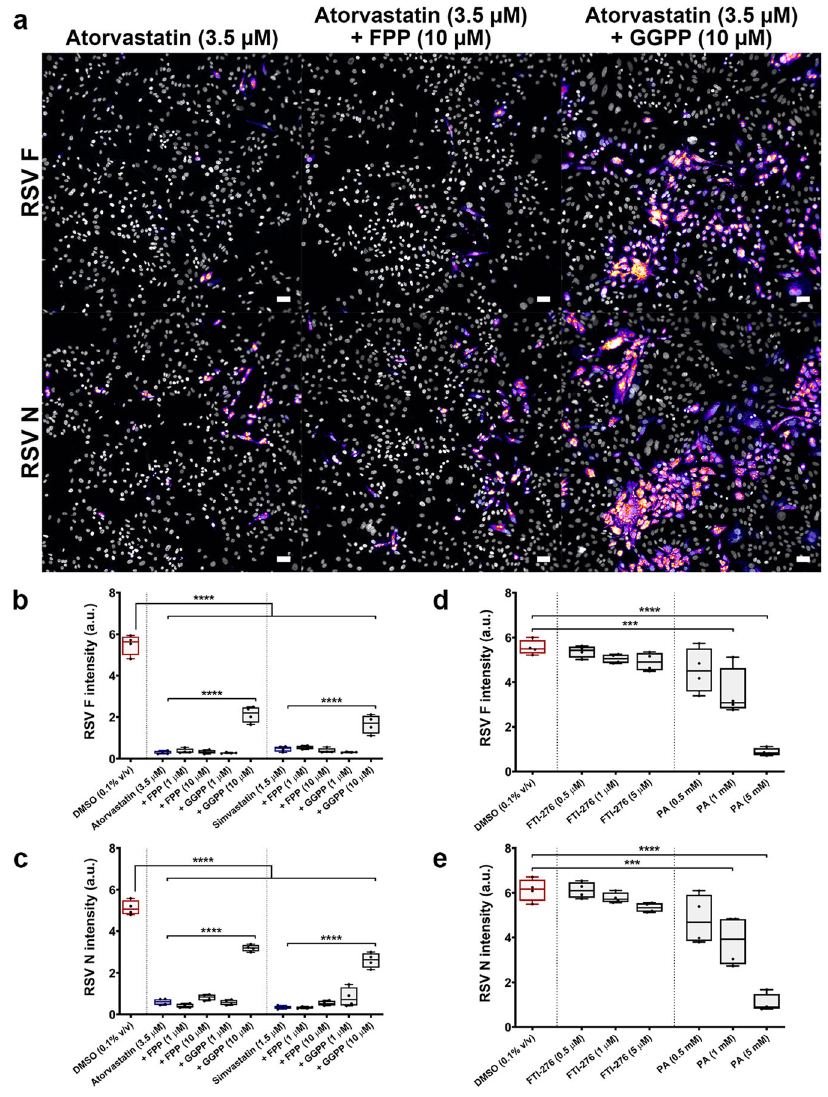
Fig. 5 Protein geranylgeranylation is speci fi cally required for RSV infection. RSV-infected cells were co-treated 2 h post-viral exposure with statins and isoprenoids, farnesyl pyrophosphate (FPP) or geranylgeranyl pyrophosphate (GGPP). a Representative images of RSV A2-infected HEp-2 cells (MOI 0.5) acquired 48 h p.i., stained for F and N. Atorvastatin (3.5 µ M) inhibits the virus, which is partially rescued by co-treatment with GGPP (10.0 µ M), but not with FPP (10.0 µ M). Scale bars = 100 µ m. b – e Quanti fi cation of F and N immuno fl uorescence 48 h p.i. b , c Exogenous addition of GGPP (10.0 µ M) partially rescued the virus in the presence of atorvastatin (3.5 µ M) and simvastatin (1.5 µ M), whereas FPP did not signi fi cantly alter the inhibitory effect of statins ( n = 4 independent measurements). d , e Treatment with the geranylgeranyltransferase inhibitor perillyl alcohol (PA) dose-dependently reduced viral protein intensity, whereas the farnesyltransferase inhibitor FTI-276 did not cause any signi fi cant changes ( n = 4 independent measurements). Both inhibitors were tested at concentrations exceeding their IC 50 . Box plots indicate the complete range (whiskers), interquartile range (box), and median (line) of measurements. The y -axis of each graph denotes protein fl uorescent intensity normalized to total nuclear count (a.u. arbitrary units). Statistics were calculated by a one-way ANOVA with a Dunnett ’ s multiple comparisons post hoc test (*** P < 0.001, **** P <